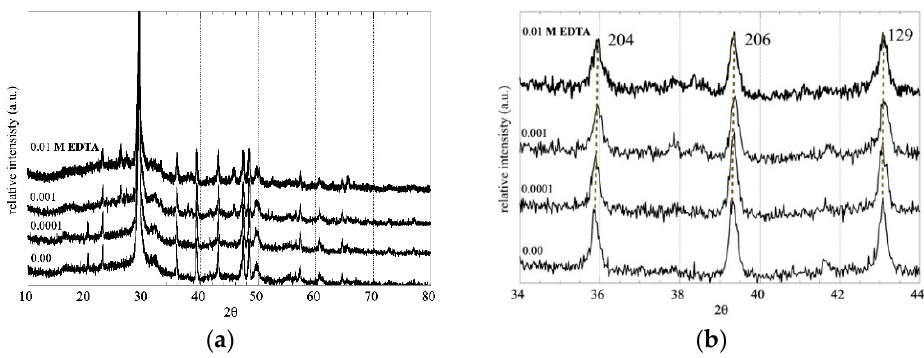
Figure 4. XRD diffractograms of C-S-H solid phases in contact with aqueous solution of varying EDTA concentration ( a ); magnification ( b ).